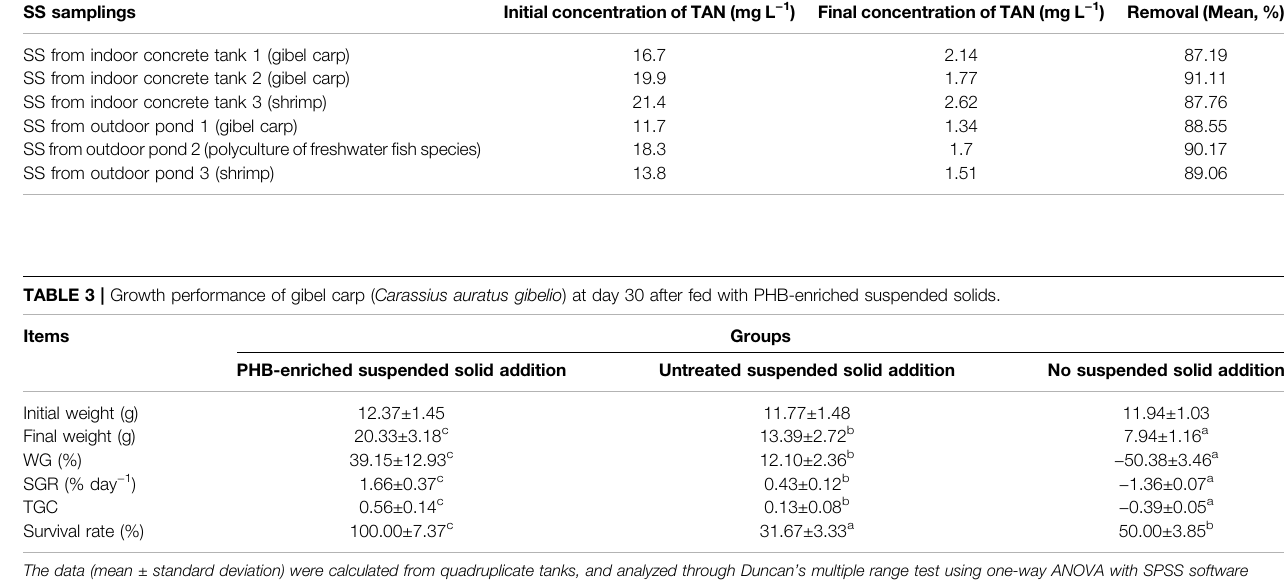
The data (mean ± standard deviation) were calculated from quadruplicate tanks, and analyzed through Duncan ’ s multiple range test using one-way ANOVA with SPSS software (version 24.0). WG, weight gain; SGR, special growth rate; TGC, thermal growth coef fi cient. Values marked with a different superscript for the same row are signi fi cantly different among groups ( p < 0.05).